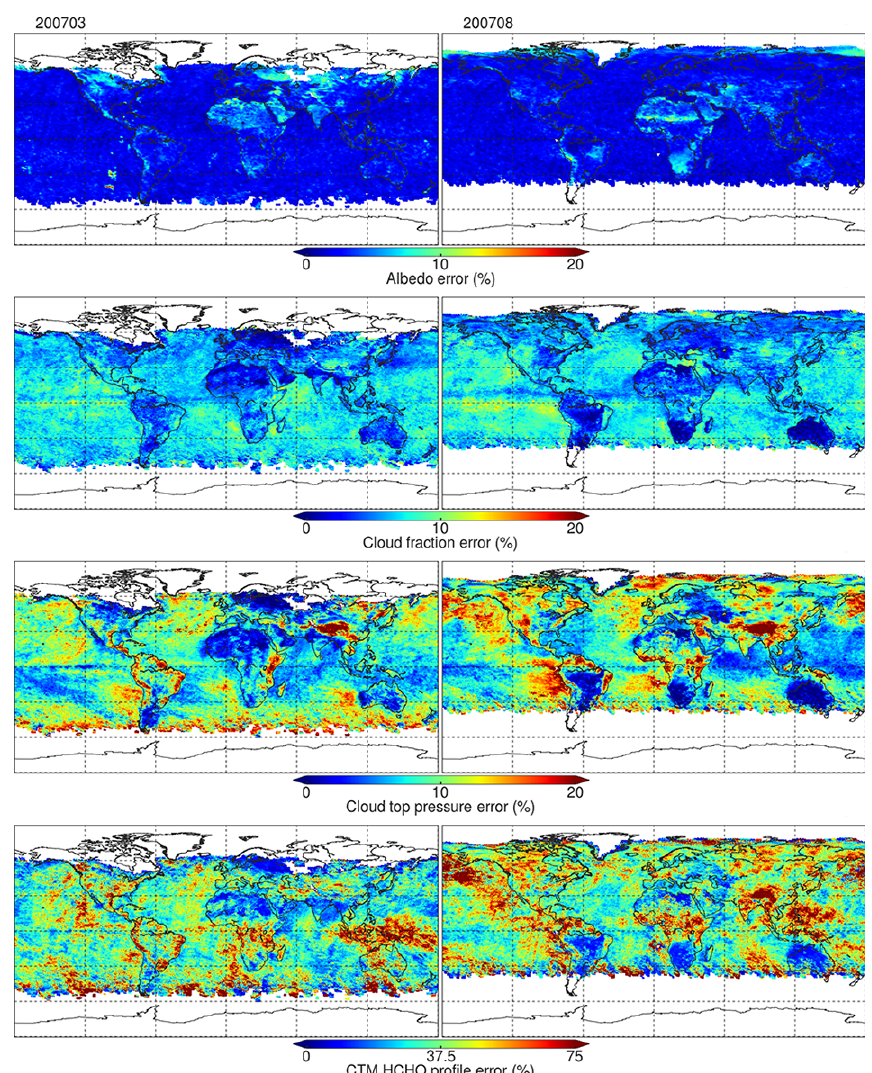
Figure 10. Monthly mean GOME-2 component albedo, cloud fraction, cloud-top pressure and CTM HCHO profile AMF errors for March (left) and August (right) 2007. Errors are gridded on to a 0.25 ◦ × 0.25 ◦ grid using observations with cloud fractions <